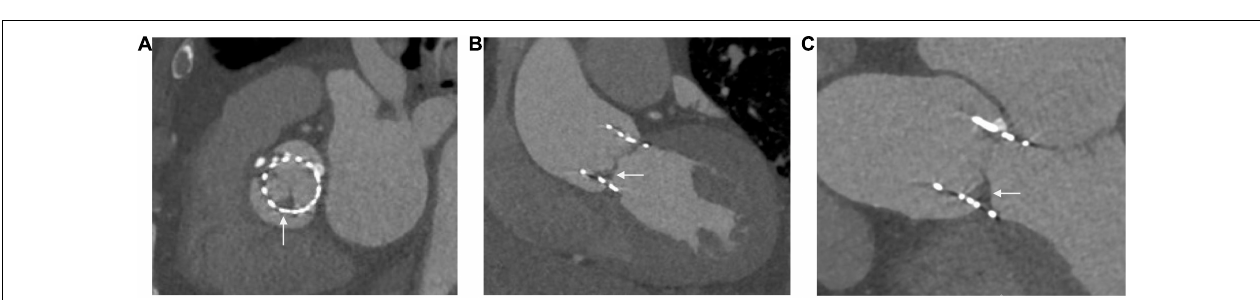
FIGURE 3 | Steps in planning for mitral intervention in a patient with a heavily calcified mitral annulus. (A) 2D ECG-gated CT scan. Pre-existing TAVR valve in aortic position, with dense calcification of the mitral annulus. (B) Coronal view. 3D volume-rendered image of pre-existing TAVR valve in situ in aortic position. Cylindrical valve simulated in mitral position, thereby allowing for anatomical and geometrical calculations to be made prior to implantation. (C) 2D CT- En-face view of calcification surrounding mitral annulus. Also visible is the TAVR valve in the aortic position. (D) 3D volume-rendered en-face image of mitral annulus down through the left atrium. MAC highlighted in yellow. Panels (B,D) created courtesy of post-acquisition processing with Mimics Enlight TMVR planner, Beta version, Materialise NV Inc.